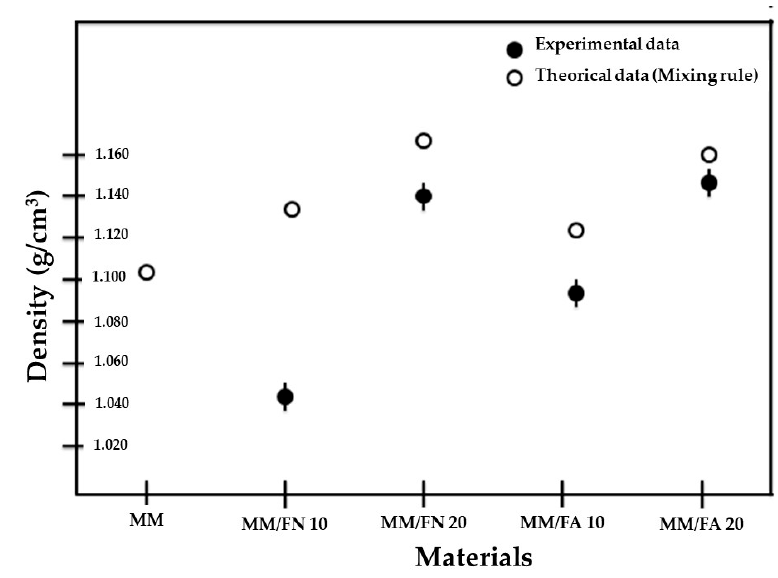
Figure 6. Density data for Mopa-Mopa resin and biobased composite with 10 and 20% native and alkalized fique fibers.